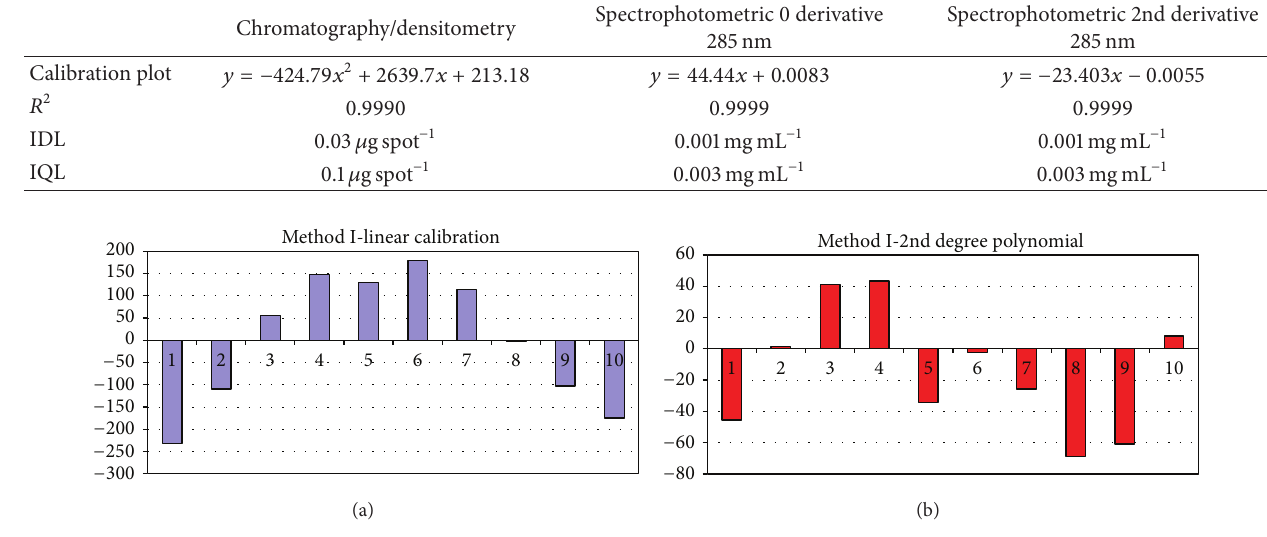
Figure 7: Analysis of residues for the linear (a) and no-linear (b) calibration plot, chromatographic method. Plot (a): a clearly visible trend. Plot (b): no particular trend.